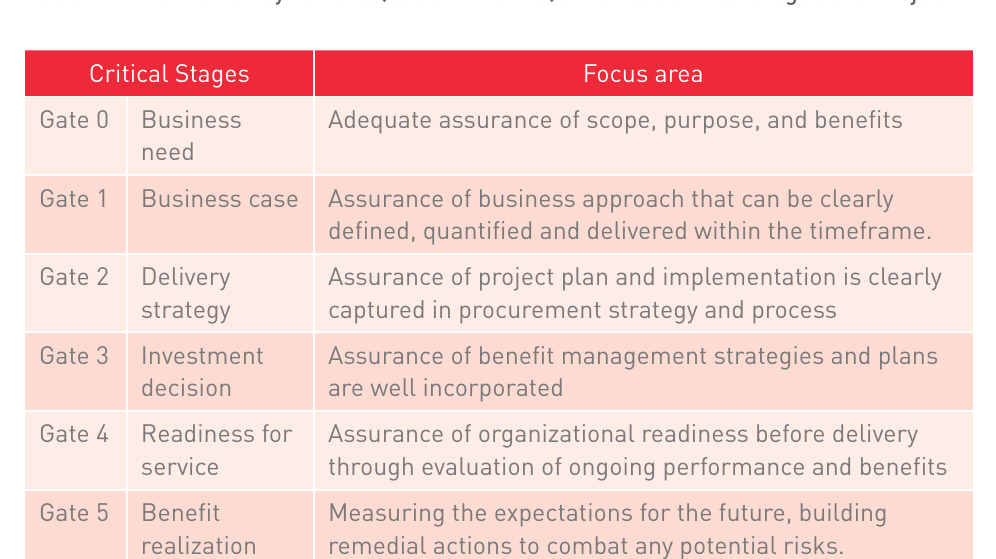
Six Gateway reviews (decision Points) at various critical stages of a